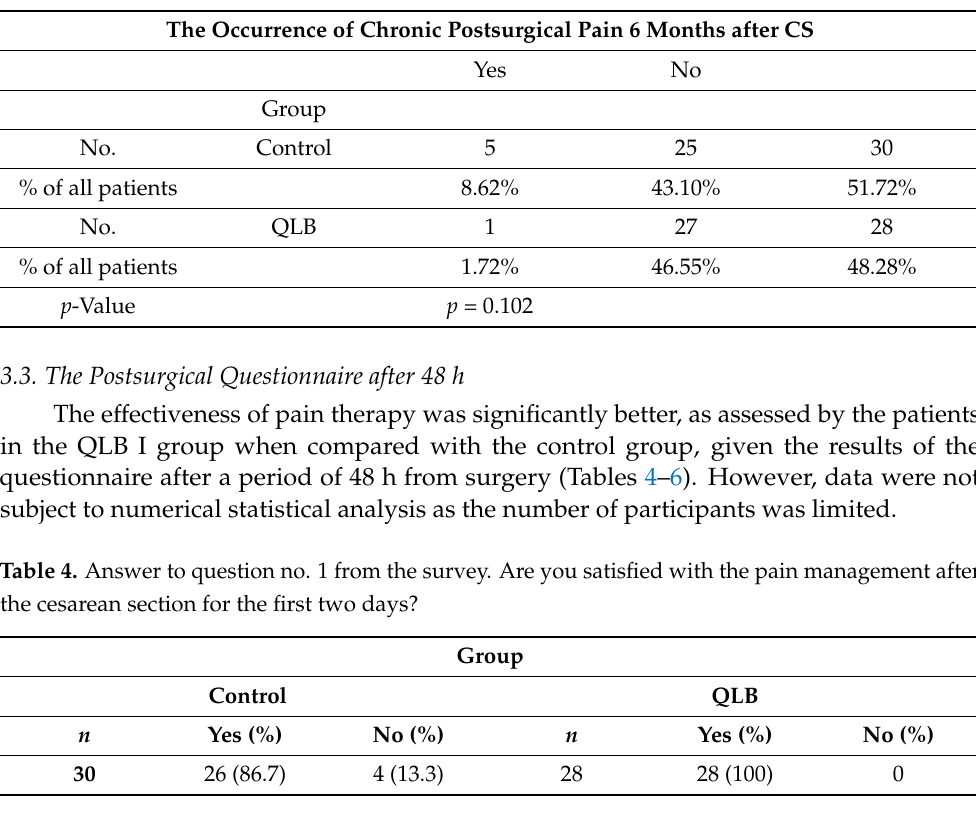
Table 3. The table presents number of patients (No.) who perceived any signs of chronic postsurgical pain at 6 months after cesarean section. A Chi-square test was used to compare responses collected from the chronic postsurgical pain phone survey.